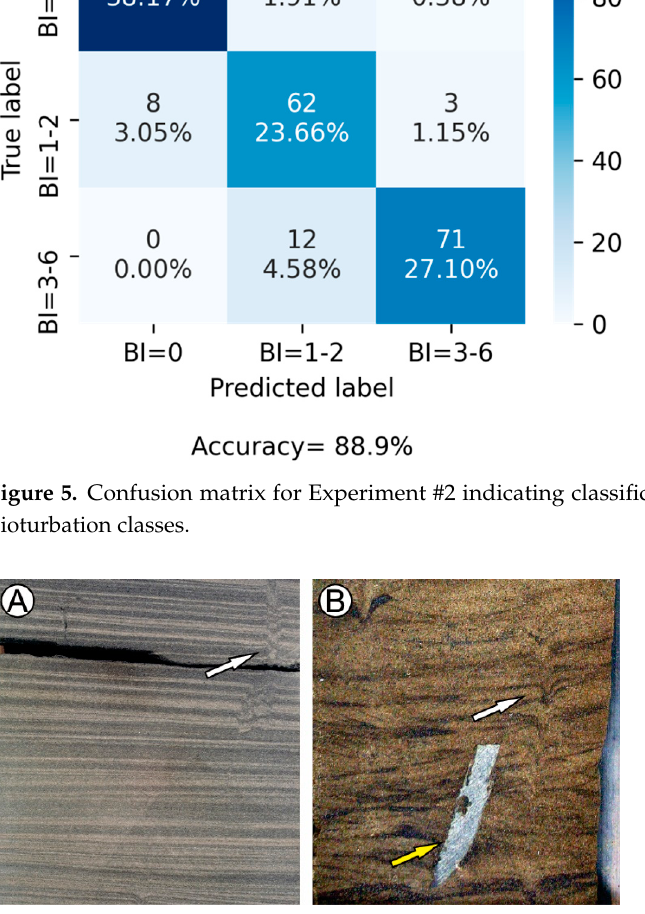
Figure 6. Two images as examples of misclassified images in EXP#2: ( A ) images displaying parallel lamination with a small escape structure (white arrow). ( B ) Image showing large escape structure (white arrow) along with a burrow or mineral growth (yellow arrow).